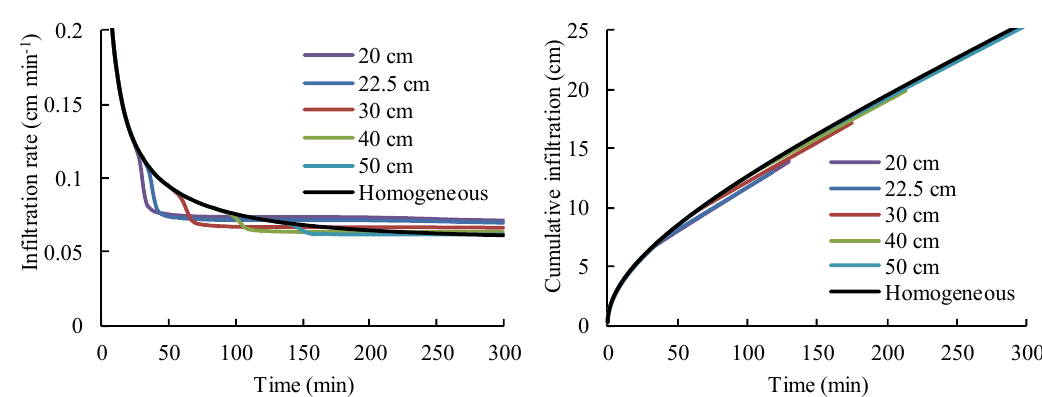
Figure 3. The variation of infiltration rate ( left ) and cumulative infiltration ( right ) with time under different buried depths of the sand interlayer for case L1S1L1.